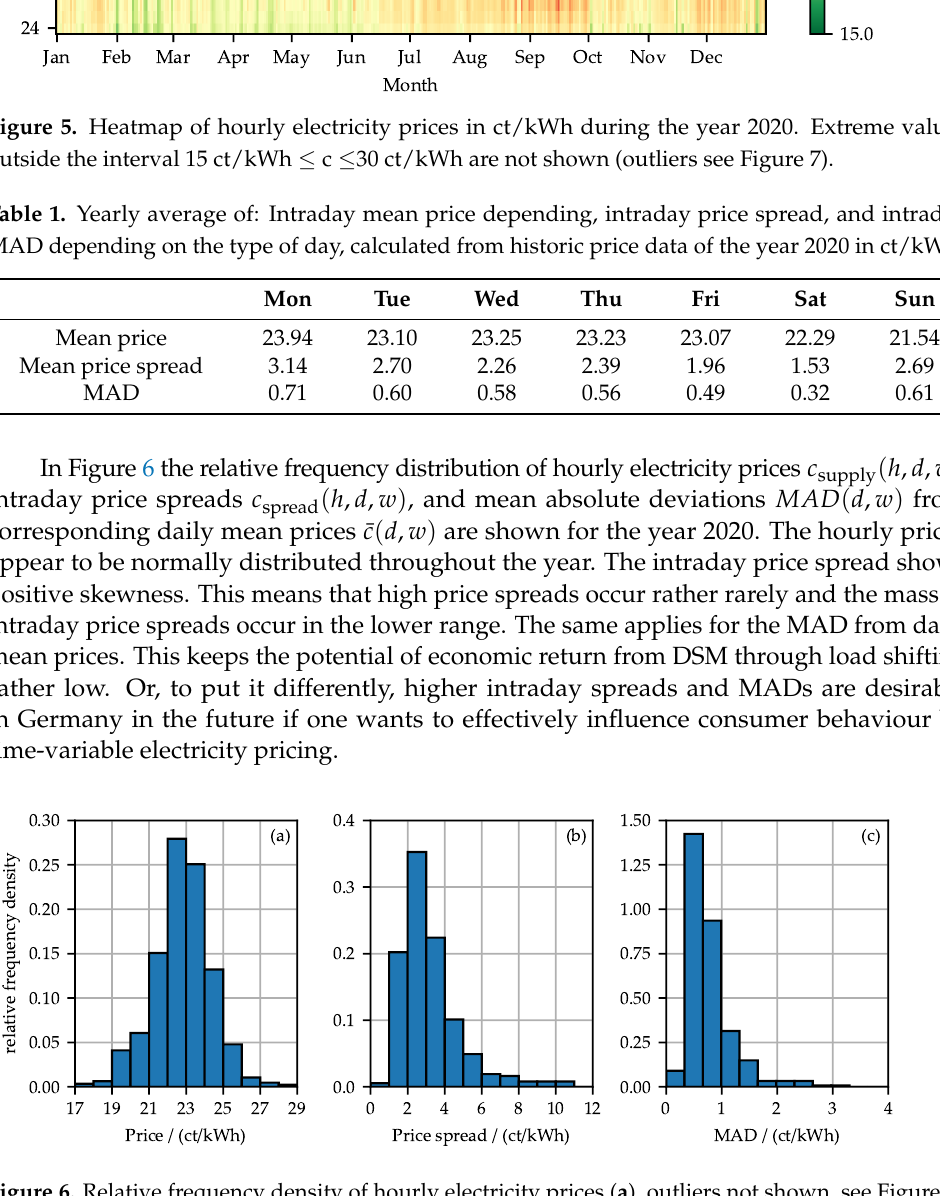
Figure 6. Relative frequency density of hourly electricity prices ( a ), outliers not shown, see Figure 7), of intraday price spreads ( b ), and of MAD from daily mean prices ( c ) in the year